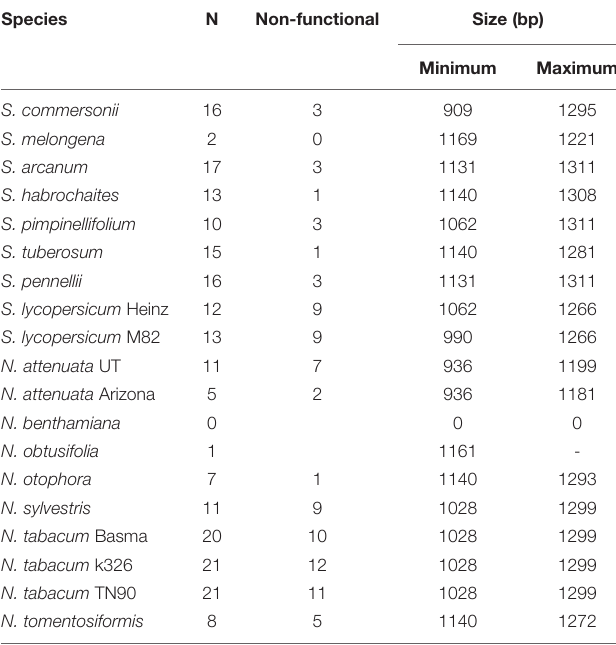
TABLE 2 | Number of SLF sequences (including pseudogenes) and size for the genomes analyzed. Species N Non-functional Size (bp)